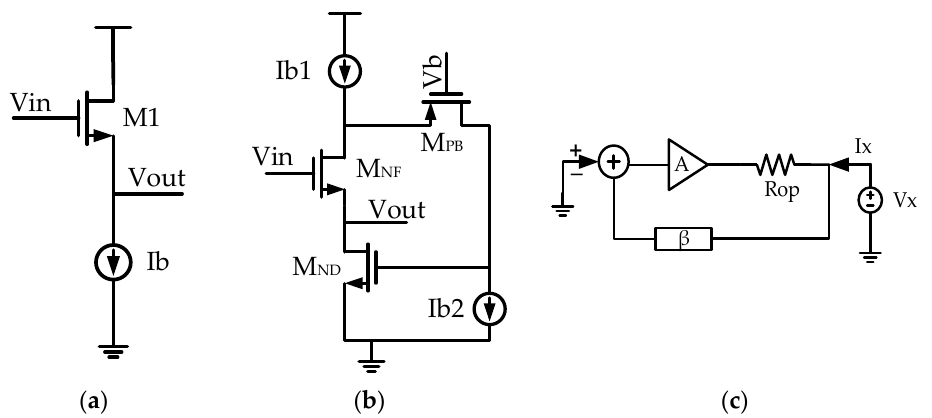
Figure 5. The block diagram of source followers: ( a ) conventional source follower; ( b ) super source follower; and ( c ) output impedance calculation circuit of the SSF.